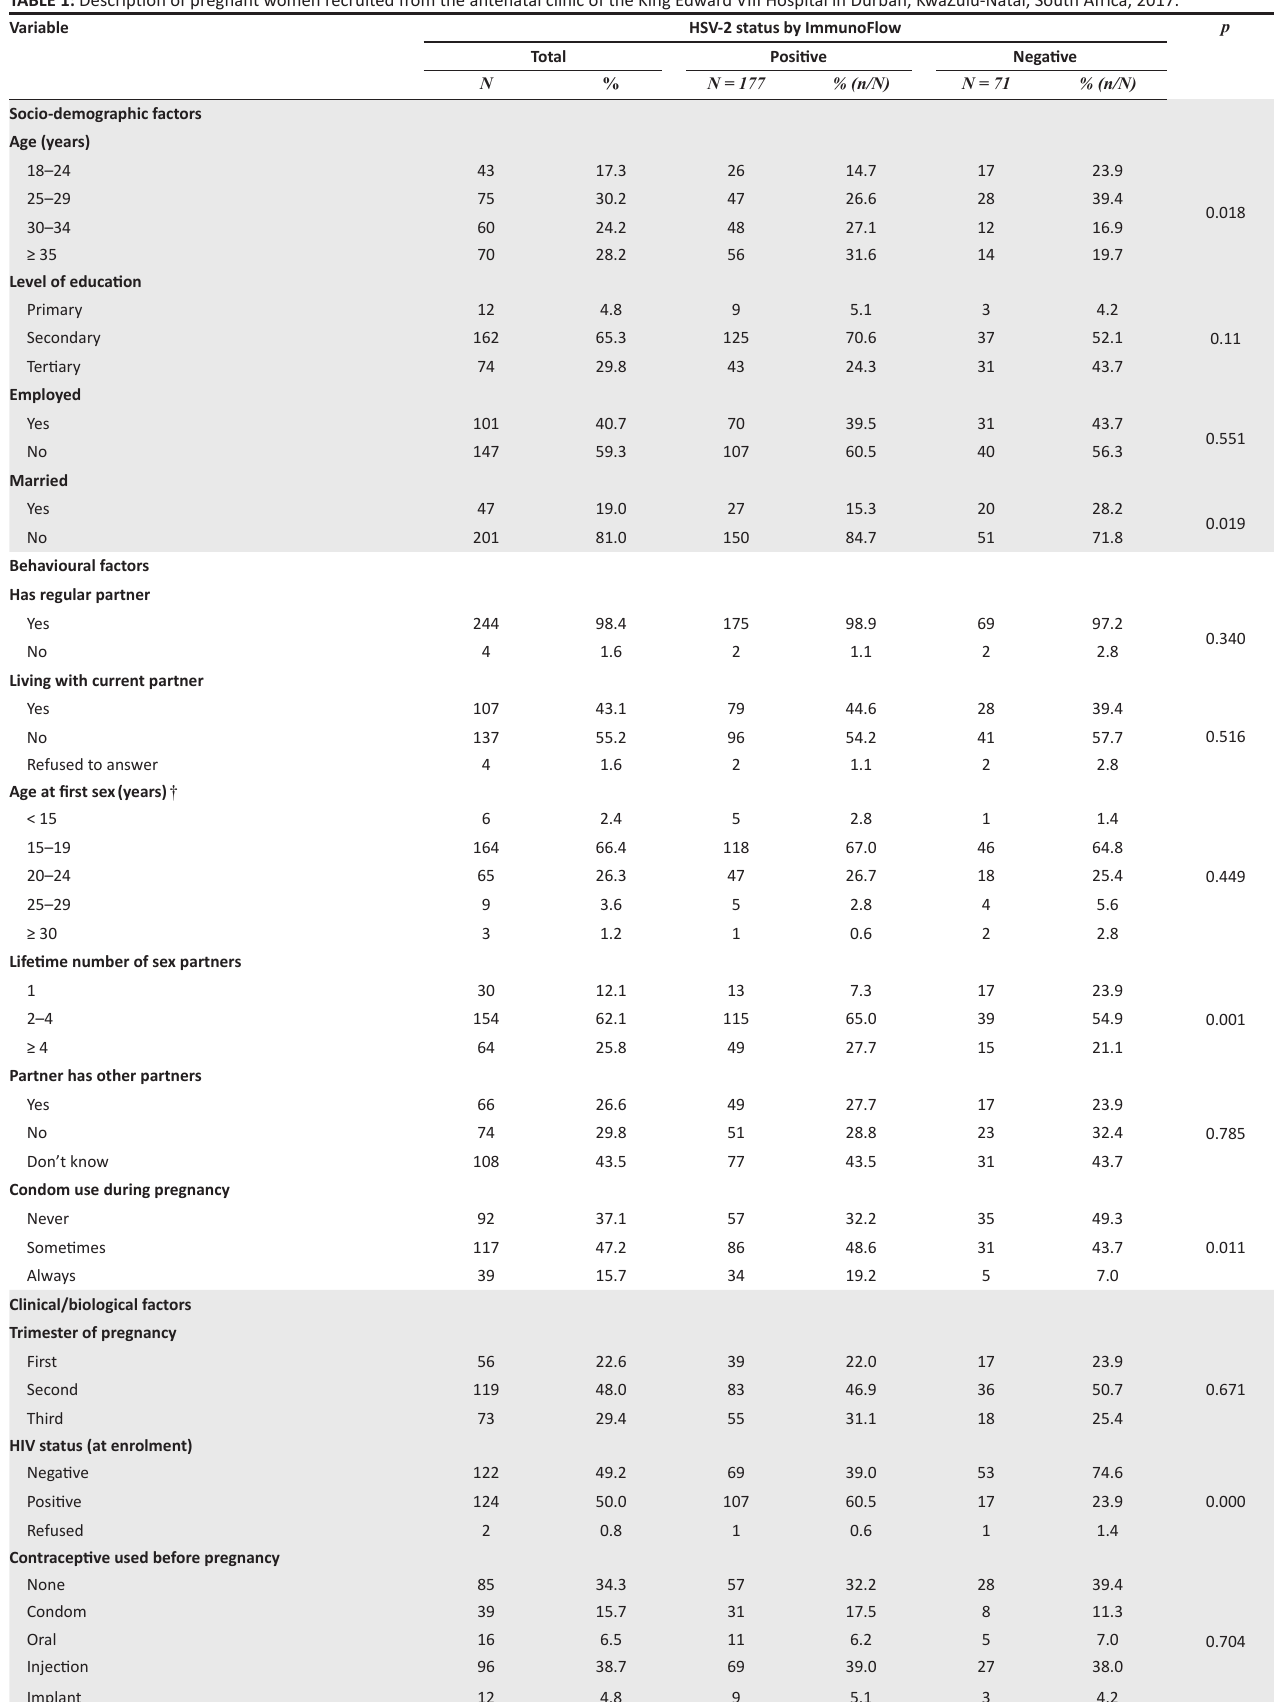
TABLE 1: Description of pregnant women recruited from the antenatal clinic of the King Edward VIII Hospital in Durban, KwaZulu-Natal, South Africa, 2017.